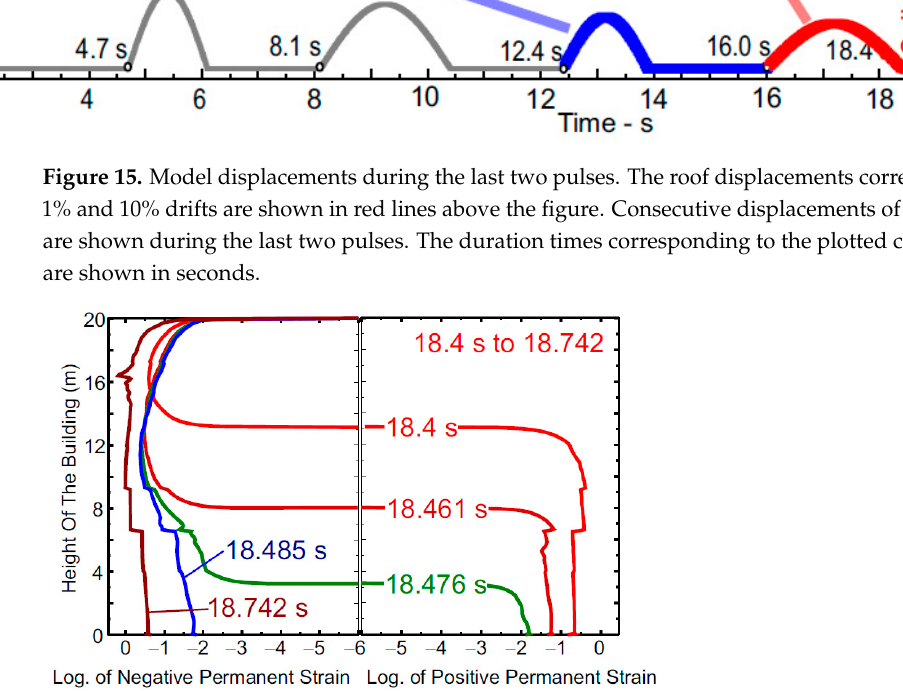
Figure 15. Model displacements during the last two pulses. The roof displacements corresponding to 1% and 10% drifts are shown in red lines above the figure. Consecutive displacements of the building are shown during the last two pulses. The duration times corresponding to the plotted configuration are shown in seconds.